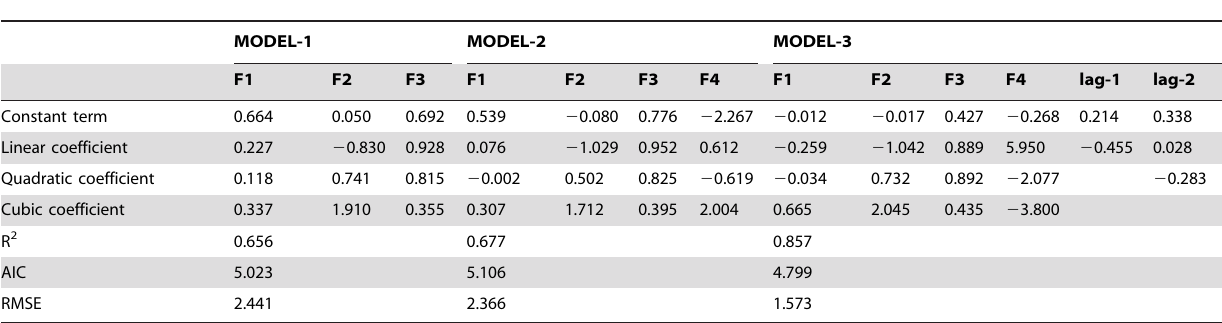
Table 5. Fitted results of the